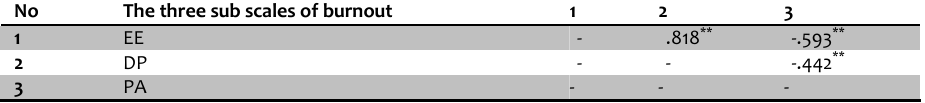
Table 15: Relations between the Three Dimensions of Burnout (EE, DP and PA) No The three sub scales of burnout 1